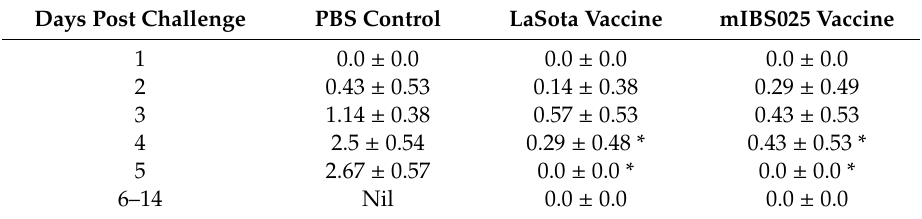
Table 4. Daily morbidity scores post challenge in vaccinated and control